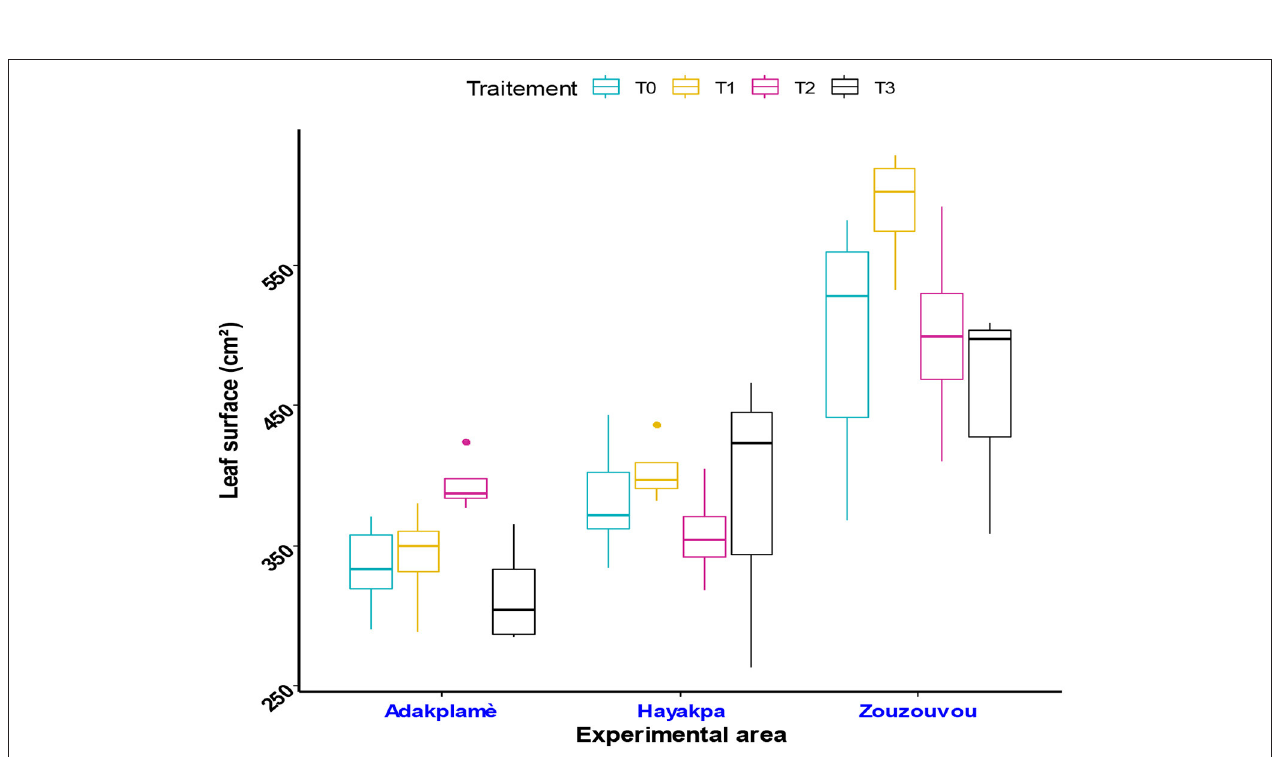
FIGURE 6 | Leaf area of maize plants as a function of treatments by zone. T 0 :100% NPK + urea; T 1 : clay + P. putida + ½ NPK + Urea, T 2 : peat + P. putida + ½ NPK + Urea, T 3 : clay-peat + P. putida + ½ NPK +